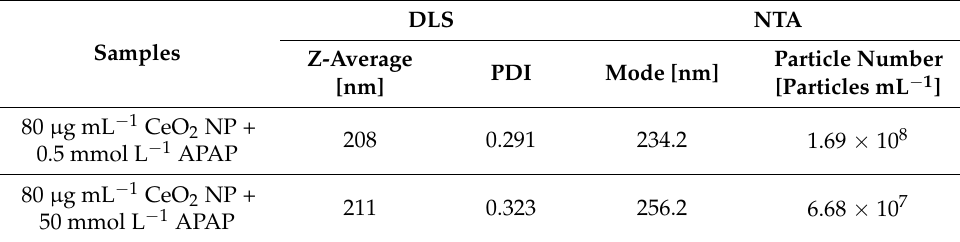
Table 1. Size, size-distribution and particle number concentration of mixtures of CeO 2 nanoparticles (NPs) and acetaminophen (APAP) as revealed by dynamic light scattering (DLS) and nanoparticle tracking analysis (NTA),